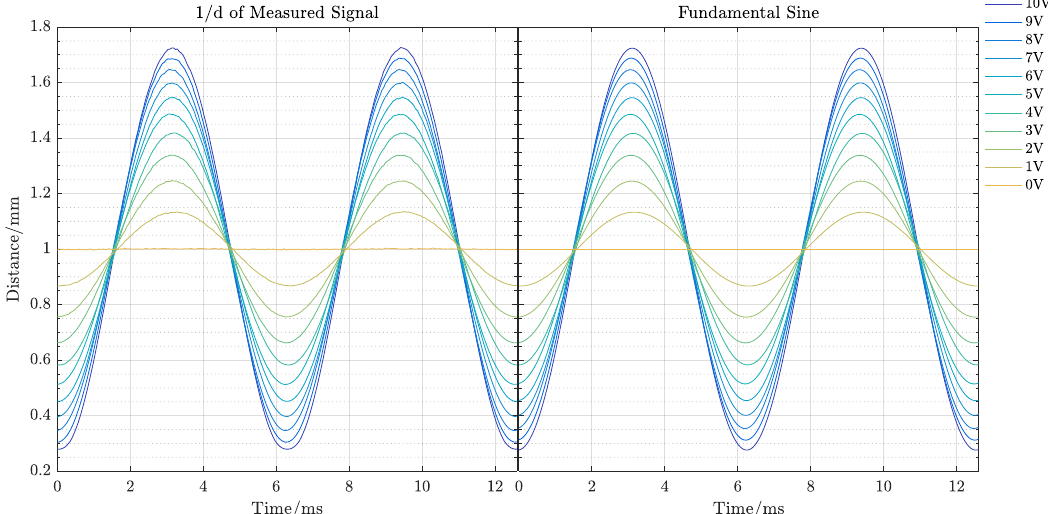
Figure 9. Comparison of the fundamental sine and sine determined from the reconstructed signal. The peaks as defined by the inverse of the curves where the membrane departs from the sensor are noisier than those measured in closer vicinity of the